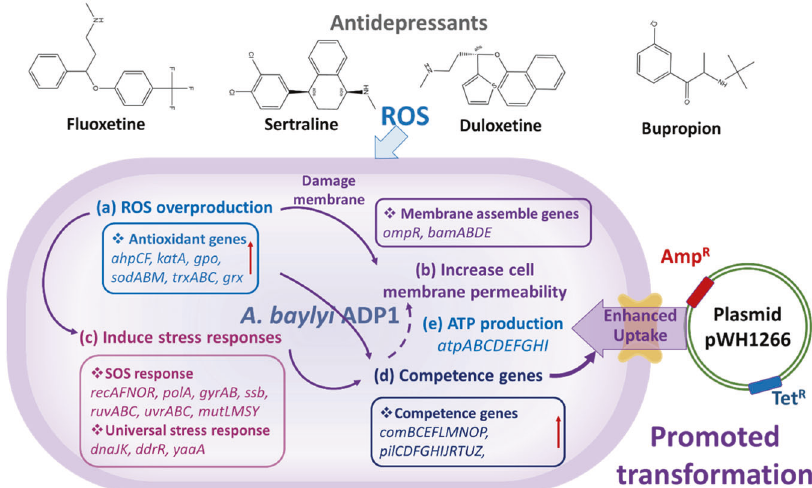
Fig. 5 Proposed mechanisms of antidepressants-promoted natural transformation of pWH1266 plasmid into A. baylyi ADP1. Firstly, the exposure to antidepressants could: a induce ROS overproduction and trigger the expression of corresponding antioxidant-related genes. Consequently, excessive ROS generated by antidepressants can ( b ) damage cell membrane and leads to increased membrane permeability. Spontaneously, oxidative stress induced by antidepressants can ( c ) trigger the SOS and stress response of A. baylyi ADP1, thereby promoting ( d ) the expression of competence-related genes. In addition, the elevated competence status might also increase membrane permeability due to the uptake of extracellular materials. Meanwhile, antidepressants also ( e ) promoted ATP production. Conclusively, the serial cellular responses under antidepressants exposure results in the enhanced transformation of A. baylyi ADP1 by plasmid